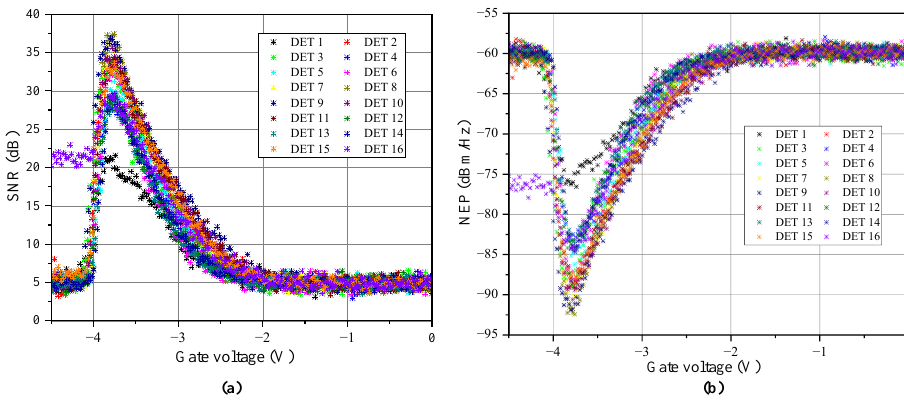
Figure 19. ( a ) SNR and ( b ) NEP at IF frequency of 1.6 MHz, LO frequency of 331.52 GHz.